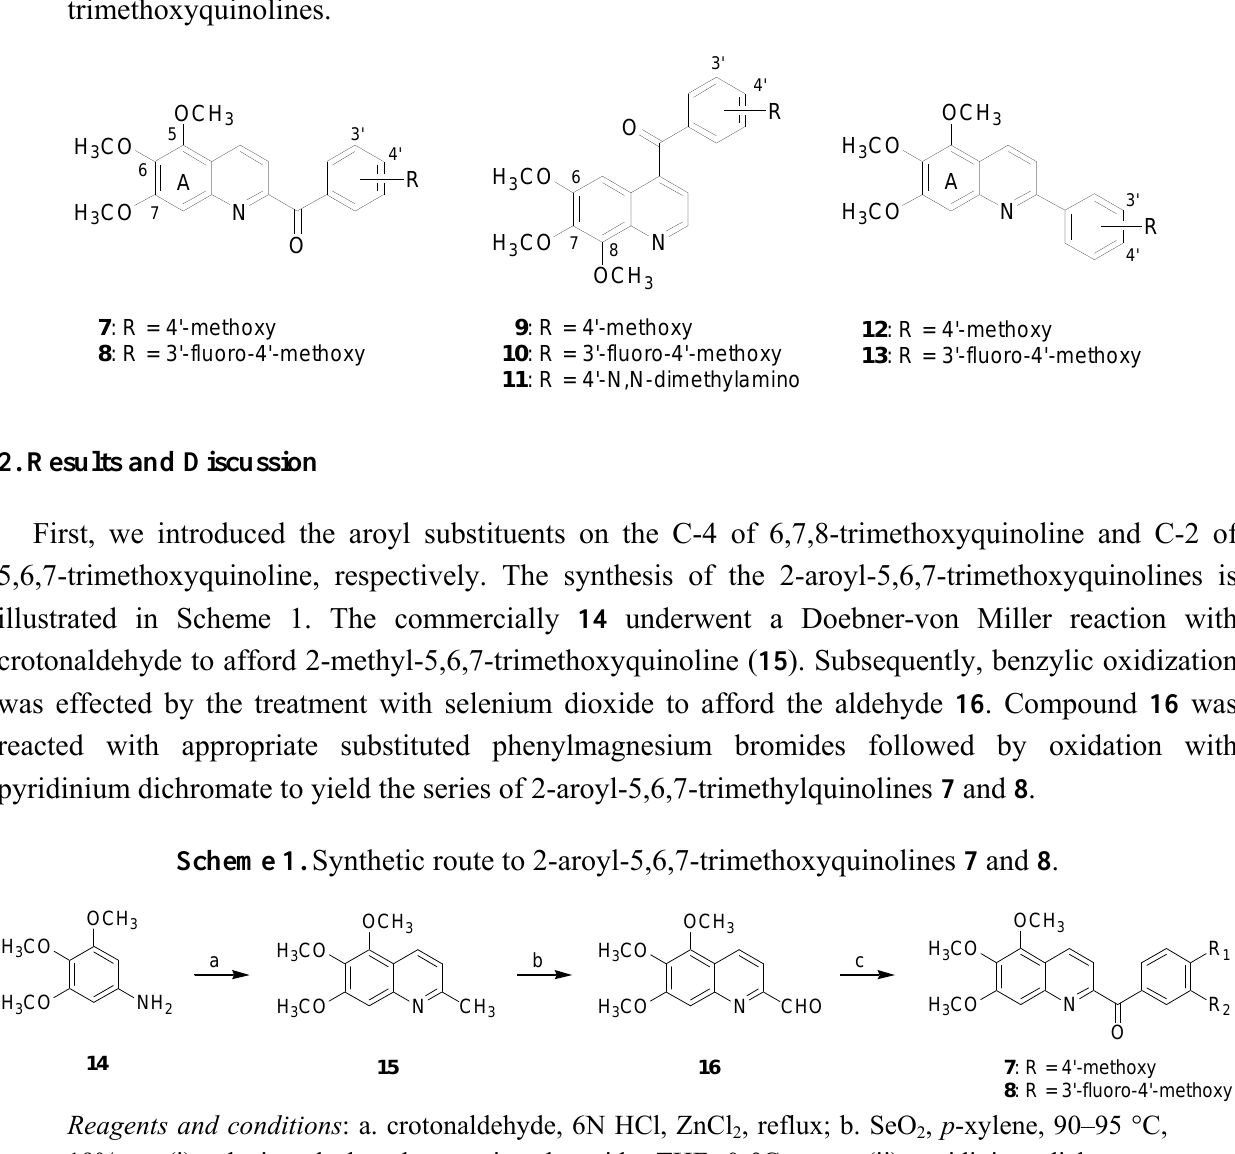
Figure 2. Synthetic 4-aroyl-6,7,8-trimethoxyquinolines, 2-aroyl- and 2-aryl-5,6,7-